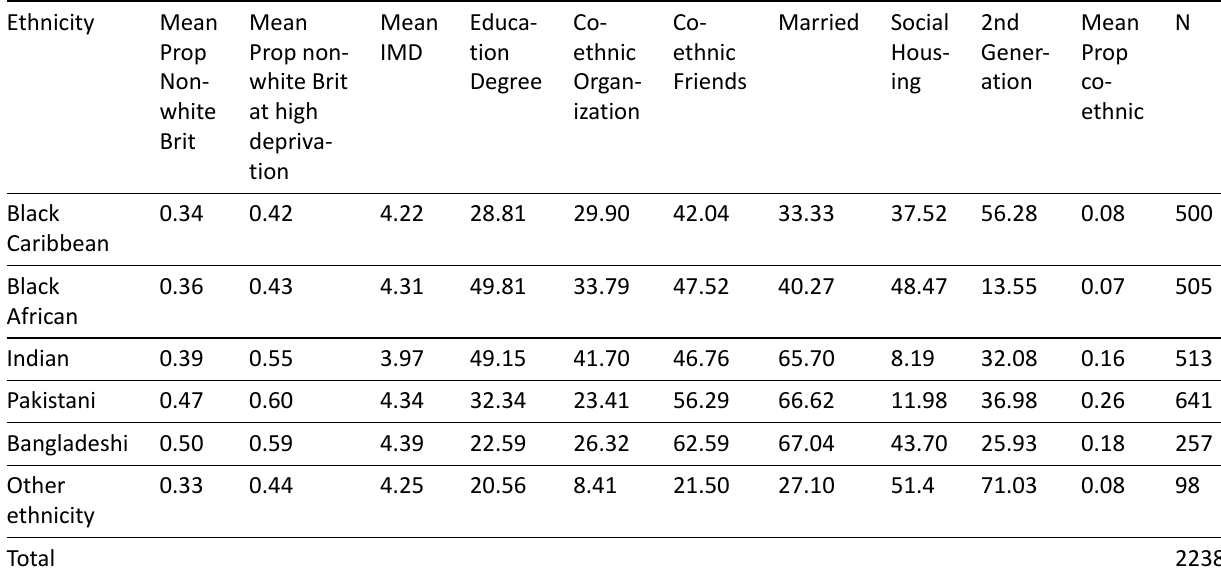
Table 2. Demographic, socio-economic, and community characteristics by ethnic group. Source: EMBES (2010); 238 retired and 277 in full time respondents were excluded from sample of working age population of